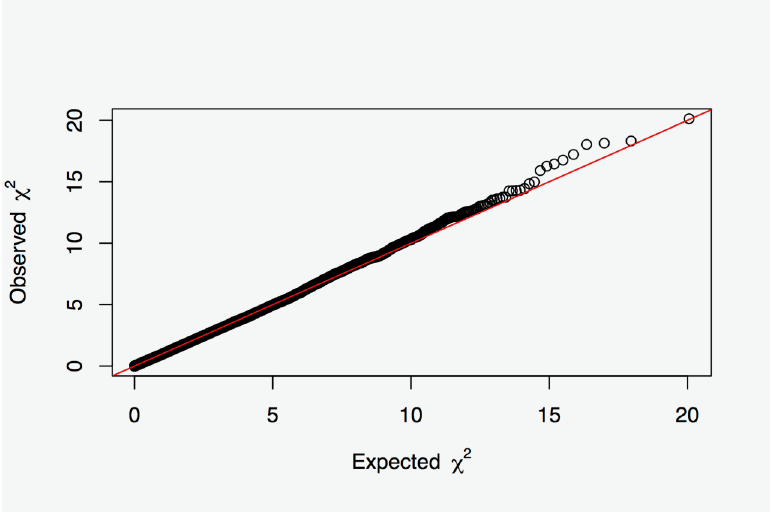
Fig 4. Q-Q plot. Quantile-Quantile plot showingP-valuesfrom GWAS. Deviationsfrom the distribution under the hypothesis (null hypothesisof no association)are